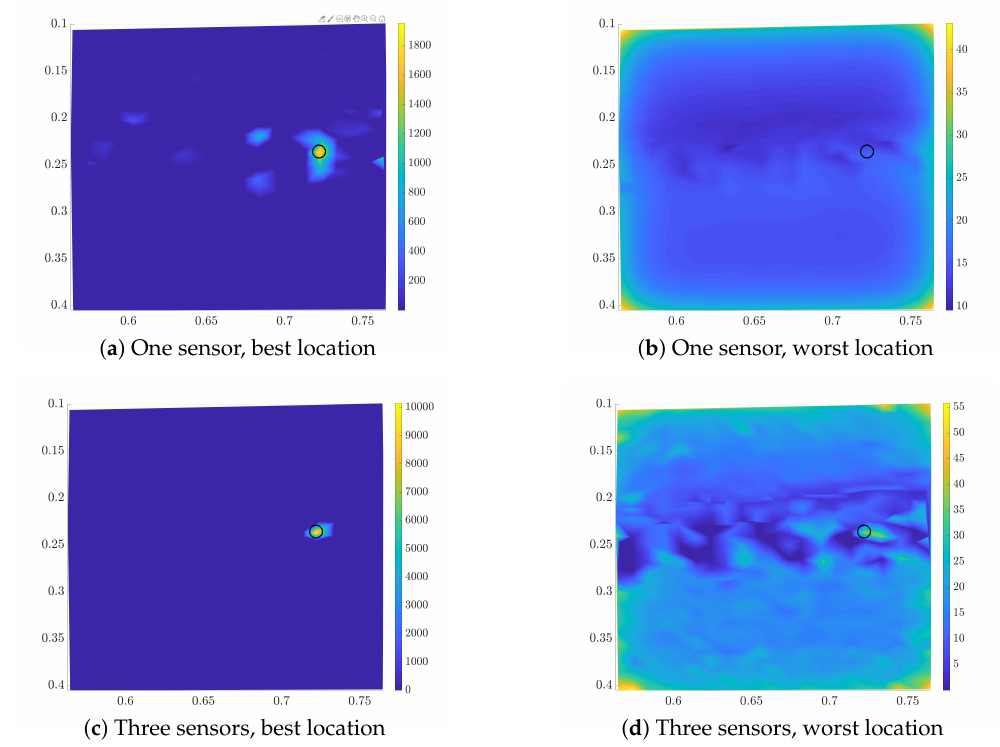
Figure 8. Estimated posterior for the final location for the best (left column) and worst (right column) sensor-location for one (upper row) and three sensors (lower row). Light colors correspond to high probability density values. We marked the actual location with a black